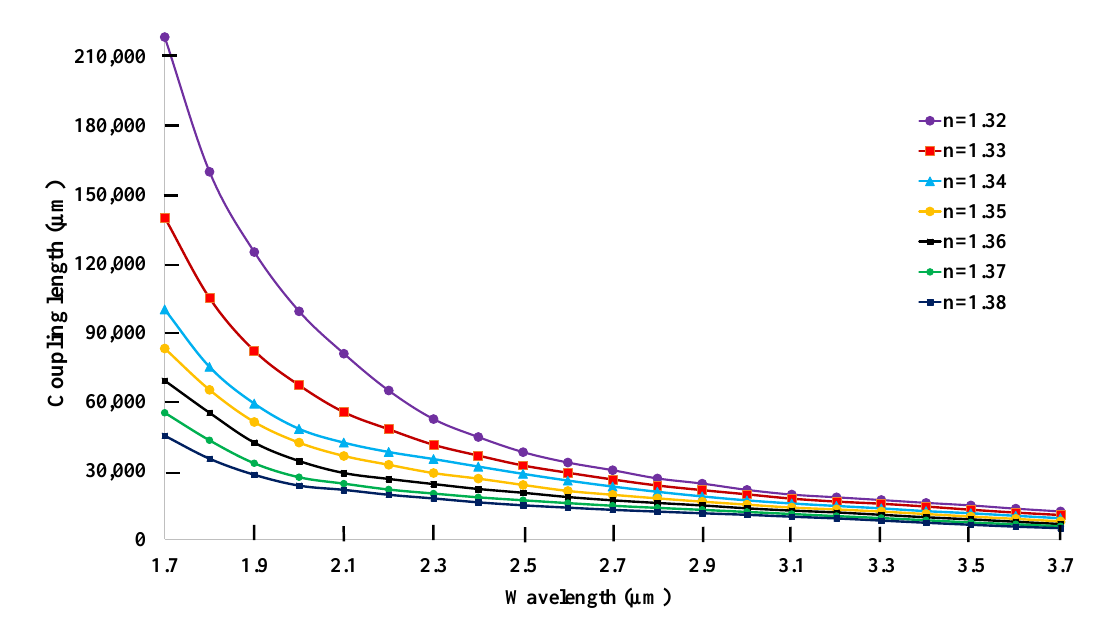
Figure 4. The coupling length of the proposed C − PCF versus wavelength.